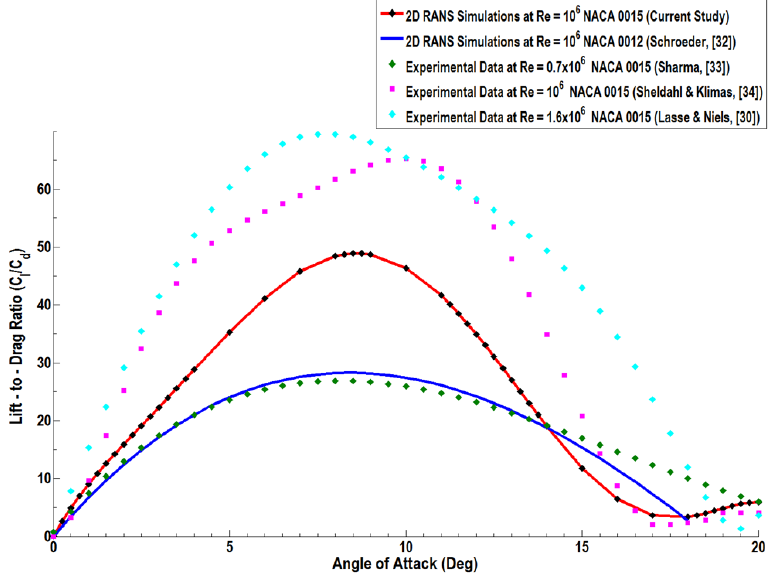
Figure 13. Comparison of the lift-to-drag 𝐶 𝑙 / 𝐶 𝑑 ratio of the airfoil at 0° flap deflection versus the angle of attack at chord Re = 10 6 with experimental data and earlier numerical results.